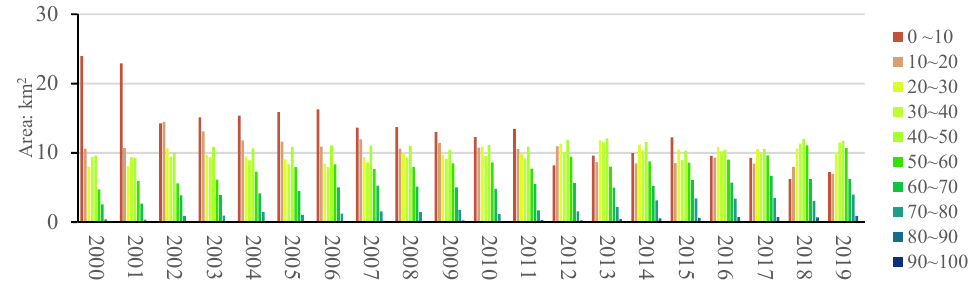
2000 2001 2002 2003 2004 2005 2006 2007 2008 2009 2010 2011 2012 2013 2014 2015 2016 2017 2018 2019